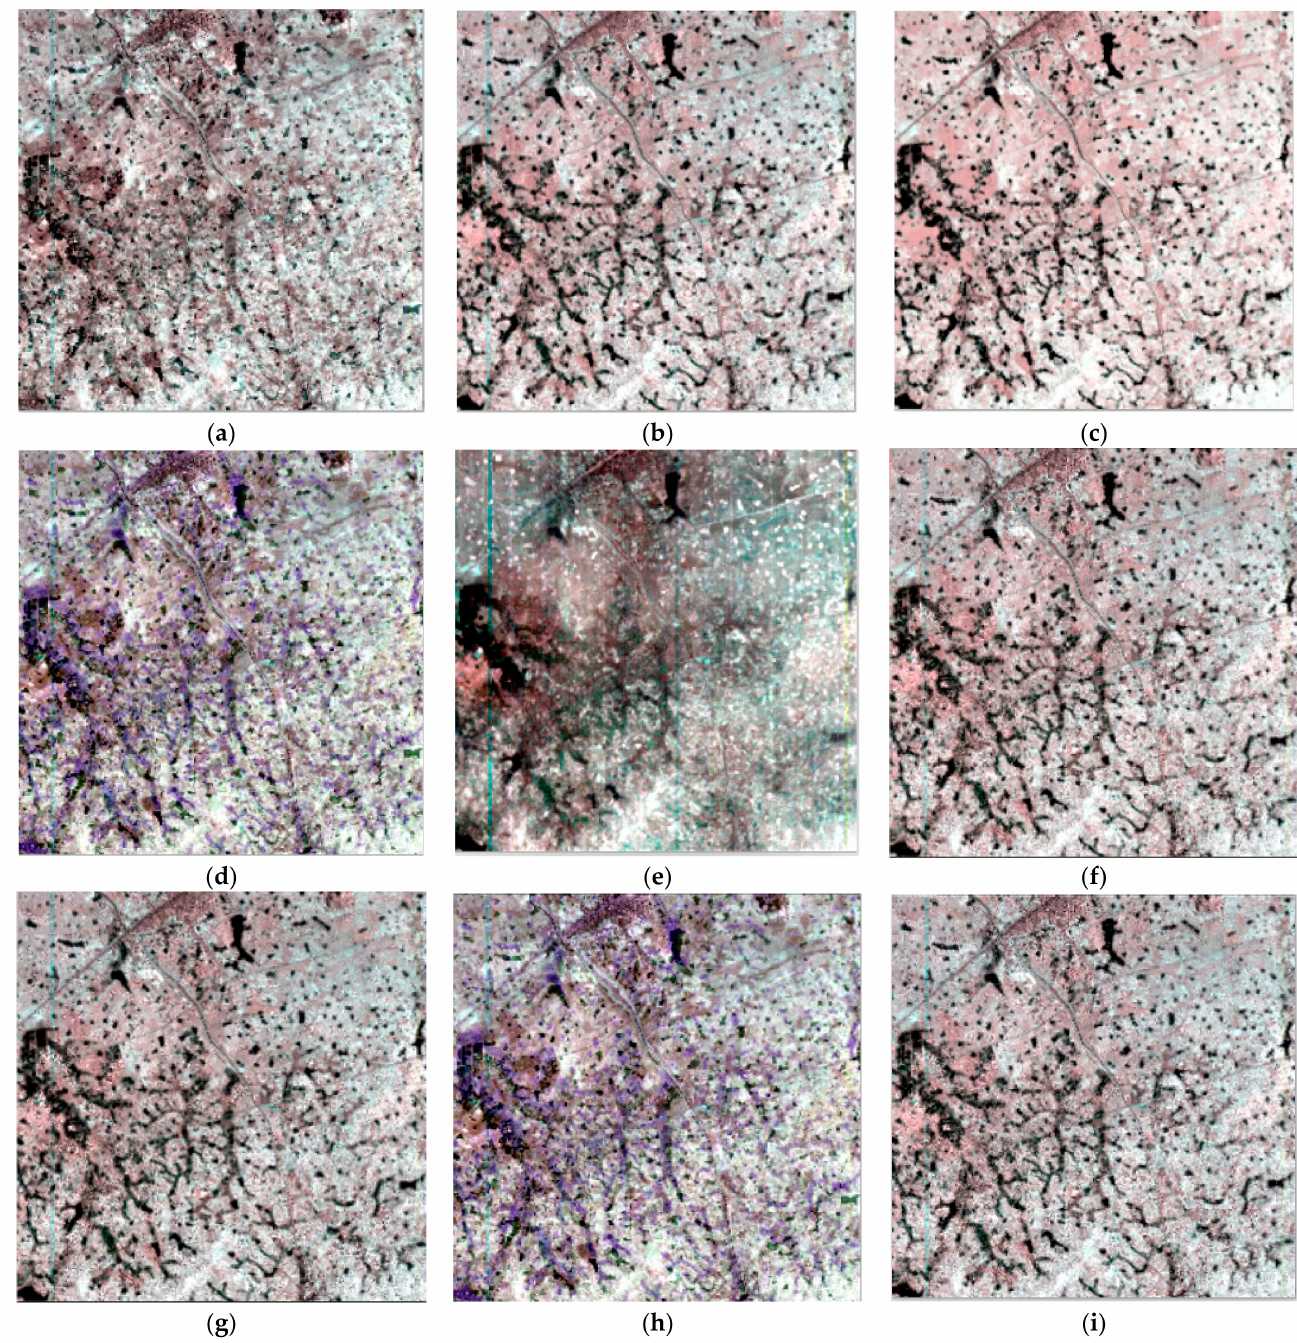
Figure 11. RGB images of the ground truth, the different methods and the proposed EDRN method on the Chaohu dataset: ( a ) Ground truth, ( b ) AWLP, ( c ) CNMF, ( d ) GIHS, ( e ) MTF_GLP, ( f ) HPF, ( g ) SFIM, ( h ) DIP-HyperKite and ( i )